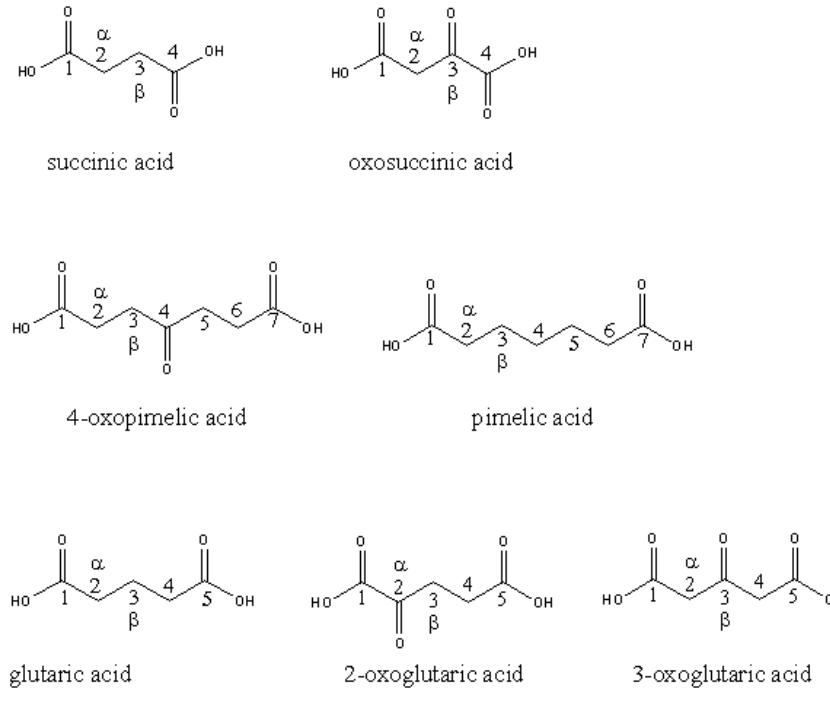
Fig. 1. Chemical structures of the molecules studied in this work. Succinic acid is added for completeness.